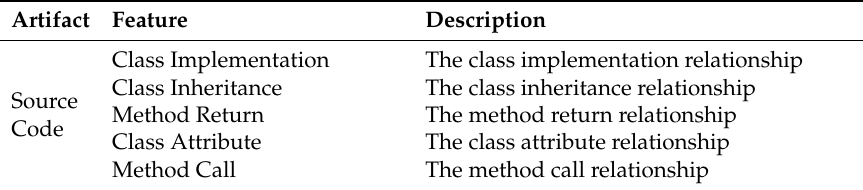
Table 3. The structural information features of source code in Phase